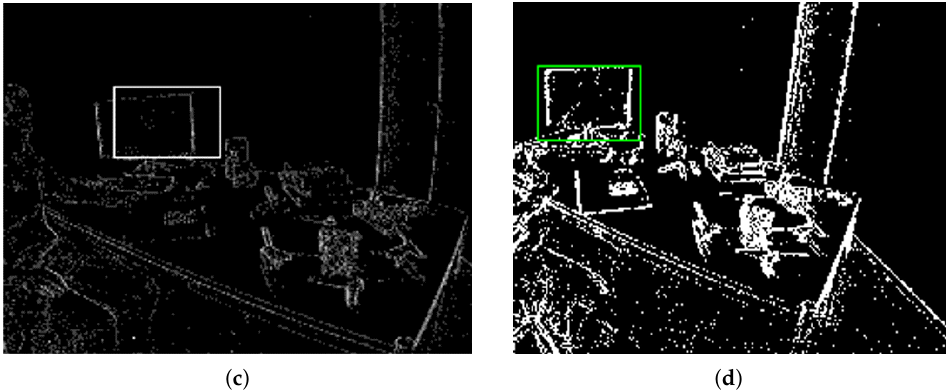
Figure 7. We compared our proposed EVtracker and e-TLD on challenging event data. ( a , c ) show the visualization results of e-TLD; ( b , d ) show the visualization results of our EVtracker. Our method can balance event resolution and spatial resolution of event data well, and the tracking results of our method are more stable and robust than the results of e-TLD. The white and green boxes represent the bounding box of the tracking. Table 2. Comparison to recent SOTA algorithms using the Success Plot metric, and the best results are highlighted bold-faced. Methods